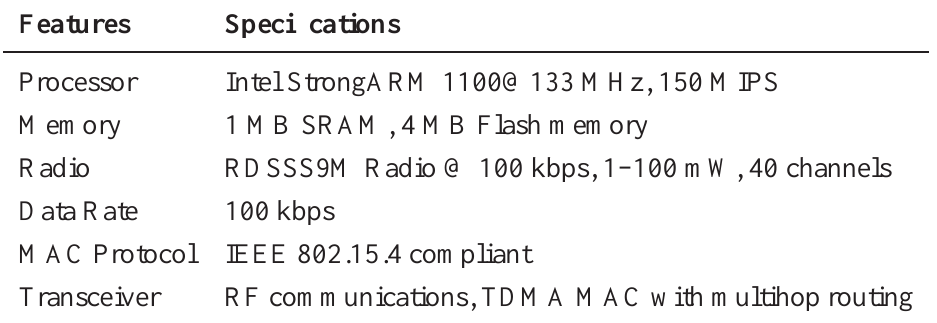
Table 2. Prototype of special purpose network connectors (RSC Wins-Hidra